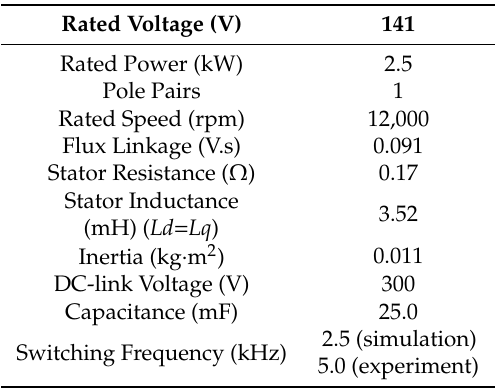
Table 1. Parameters of the PMSM / G and converter.